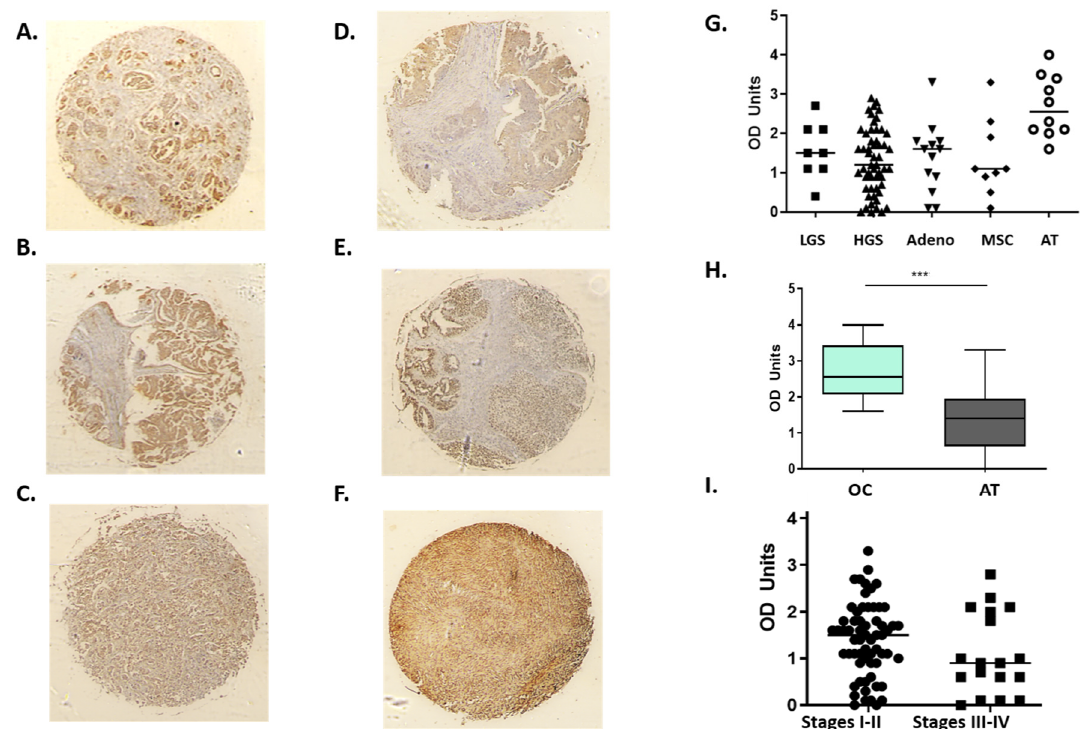
Figure 7. Staining of OC cores with H2AX. ( A ): Low grade serous (LGS), ( B ): High grade serous (HGS), ( C ): Mucinous adenocarcinoma (Adeno), ( D ): Metastatic serous carcinoma (MSC), ( E ): Endometrial adenocarcinoma, and ( F ) : adjacent to tumour ovarian tissue (NAT). Abundance of staining was detected across all different OC types with an upregulation in NAT tissue ( G ). Significant protein upregulation of H2AX (*** p = 0.0003) when all OC cores were compared to NAT ( H ). Non-significant difference in H2AX staining between late (III and IV) and early stage (I and II) ( I ).